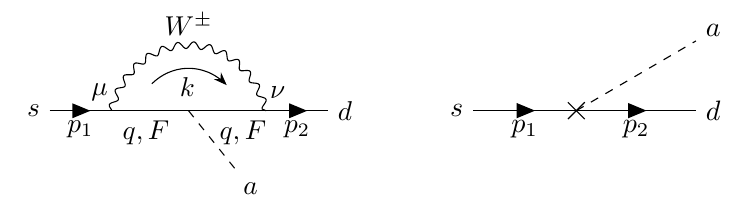
Figure 3 . Relevant one-loop contributions to the s → d + a process in our UV model. These consist of axion emissions through the quark couplings (left) as well as counterterm contributions (right). The symbol × denotes a counterterm